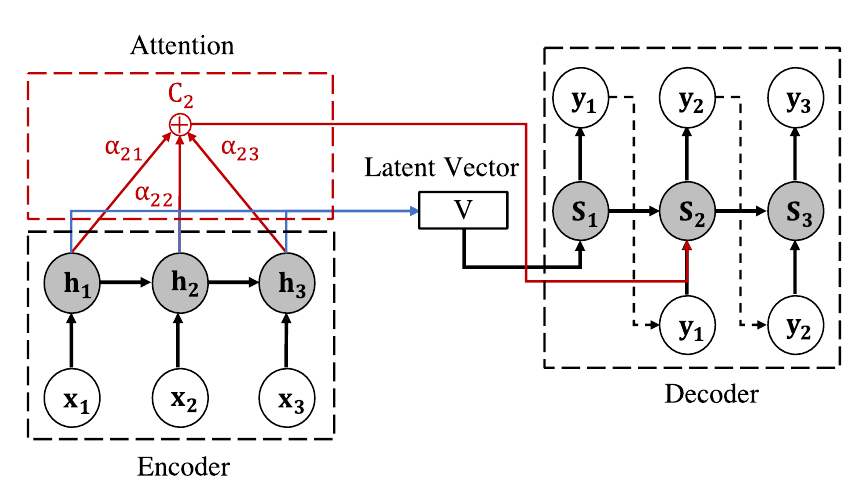
Figure 4. Structure of the encoder-decoder RNNs with attention